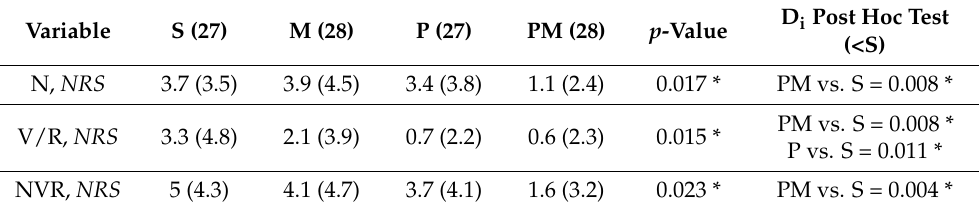
Table 5. Intraoperative NRS scores of NVR.